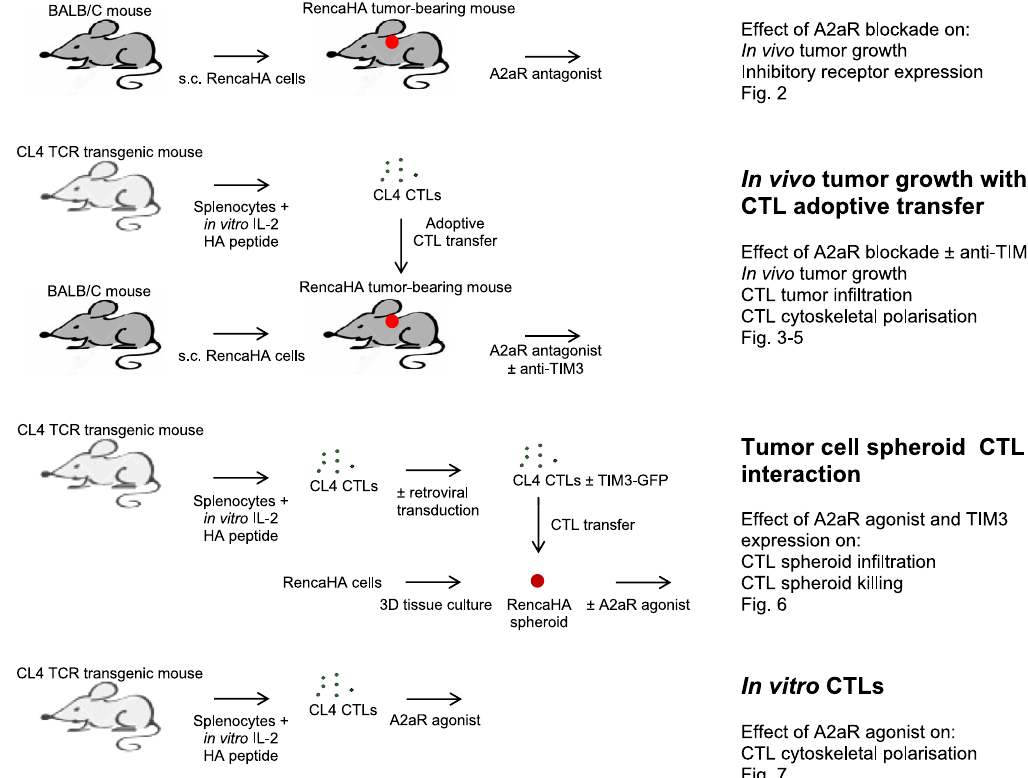
Fig. 1 Schematic representation of the experimental system. The different experimental strategies used are illustrated on the left with a list of corresponding experiments and fi gures shown for each on the